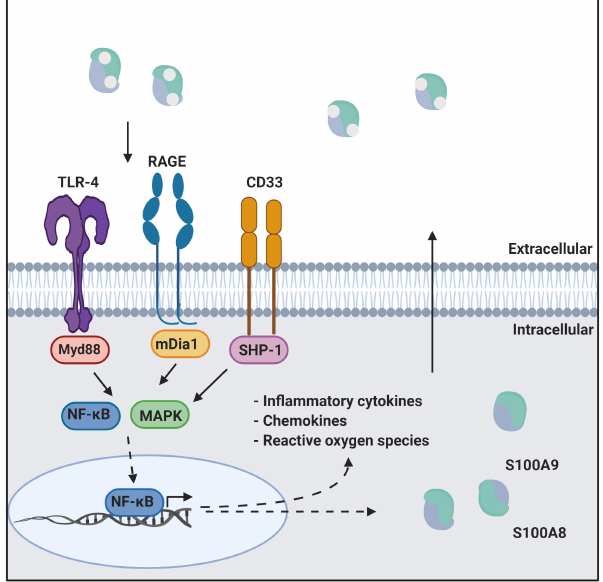
Figure 1. CP in innate immunity. CP serves as a ligand for inflammatory receptors such as RAGE and TLR4. Activation of these receptors through the MAPK dependent signaling cascade activates the NF- κ B transcription factor. This results in the expression of cytokines, chemokines, and reactive oxygen species that drive inflammation. This figure was created using BioRender.com (last accessed on 10 February